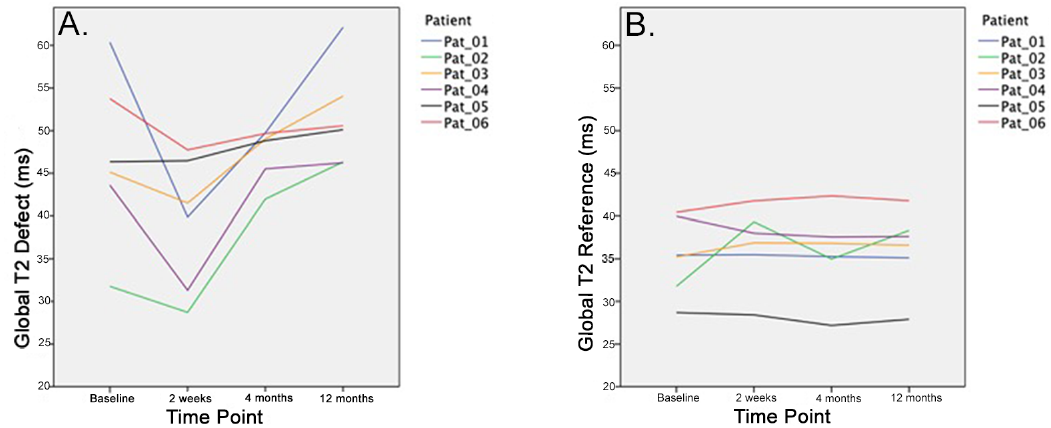
Figure 3. The global T2 values of the defect site decrease two weeks after treatment. However, an increase was observed in each patient after the first two postoperative weeks ( A ). No significant changes were observed at the reference site over the time course of 12 months ( B ).